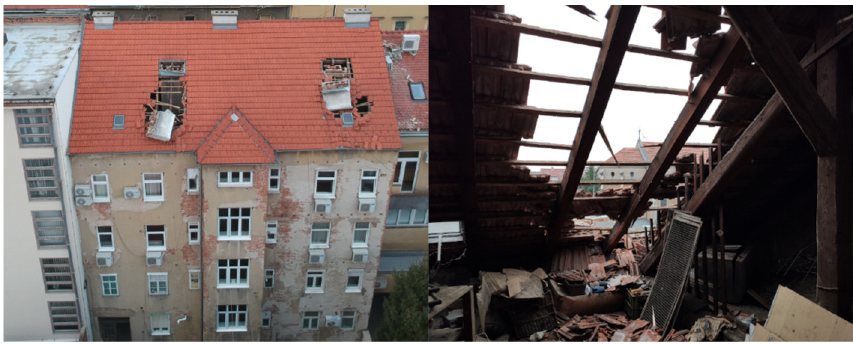
Figure 4. Damages to the roofs and chimneys. (Photo credit: Mislav Stepinac).